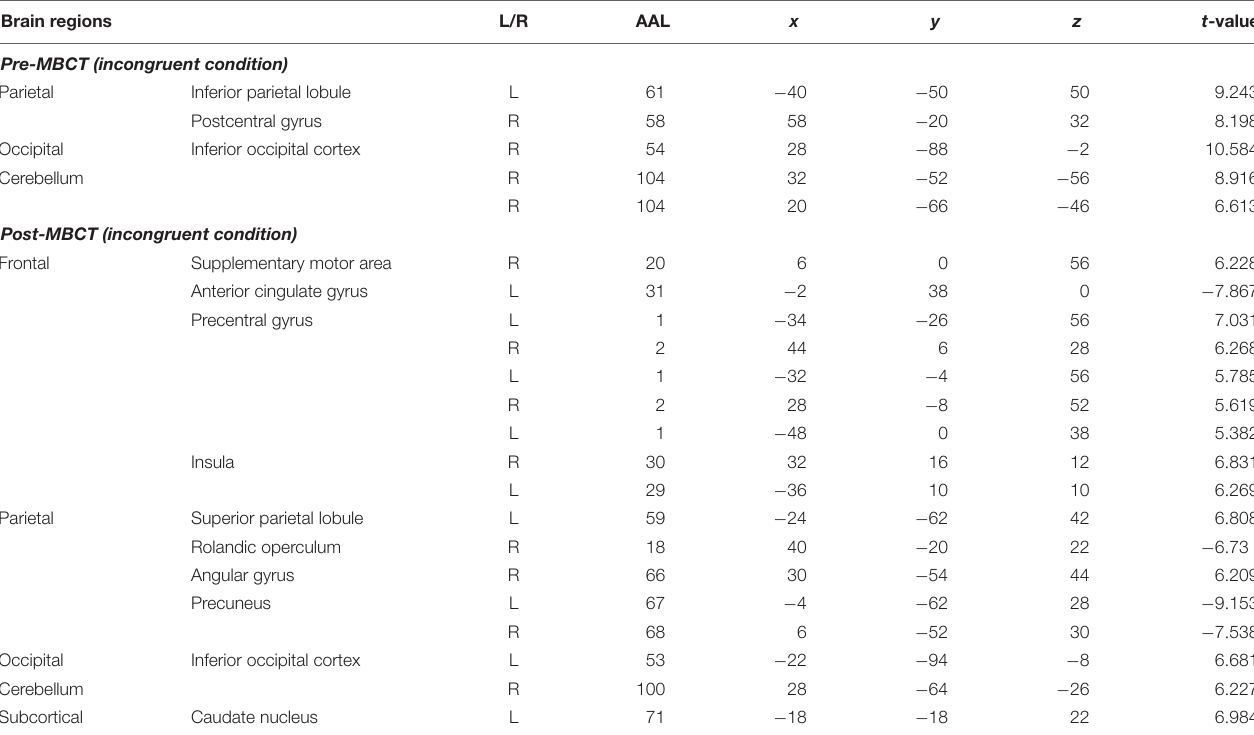
TABLE 4 | Peak locations of brain activities associated with incongruent condition during the numerical Stroop task, including before and after the MBCT intervention (AlphaSim corrected p < 0.05). Brain regions L/R AAL x y z t -value